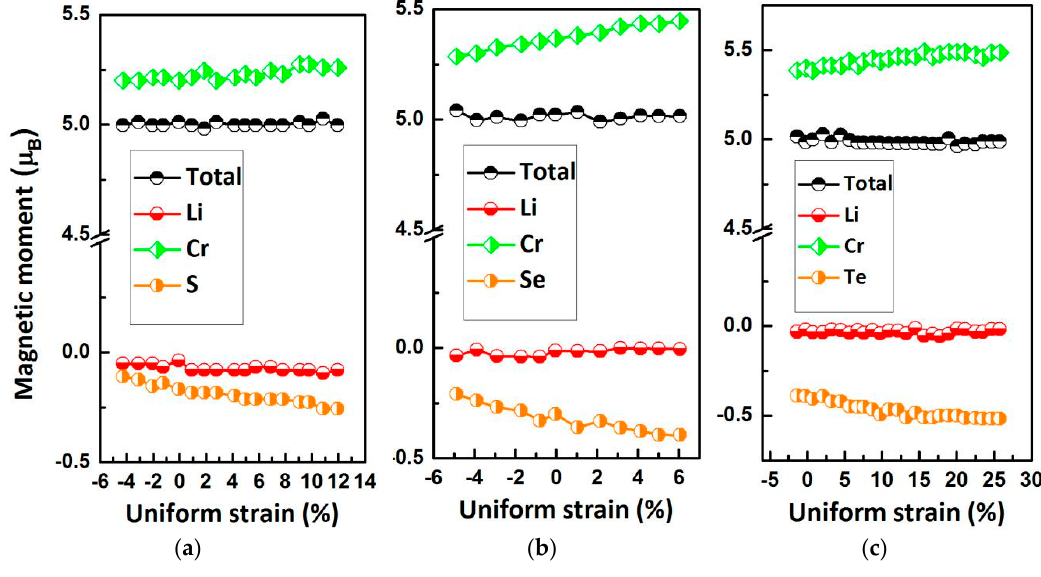
Figure 8. Total and atomic magnetic moments as functions of the lattice constants for the LiCrS ( a ), LiCrSe ( b ) and LiCrTe ( c ) alloys in type II arrangement.